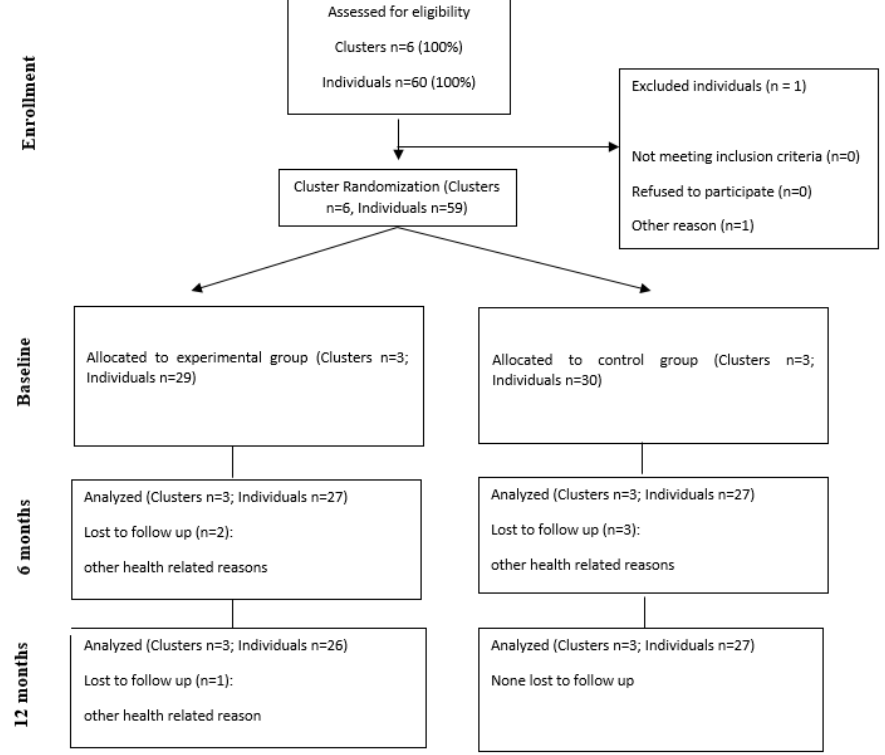
Figure 1. Flowchart of the cardiac rehabilitation intervention. CONSORT: Consolidated Standards of Reporting Trials.